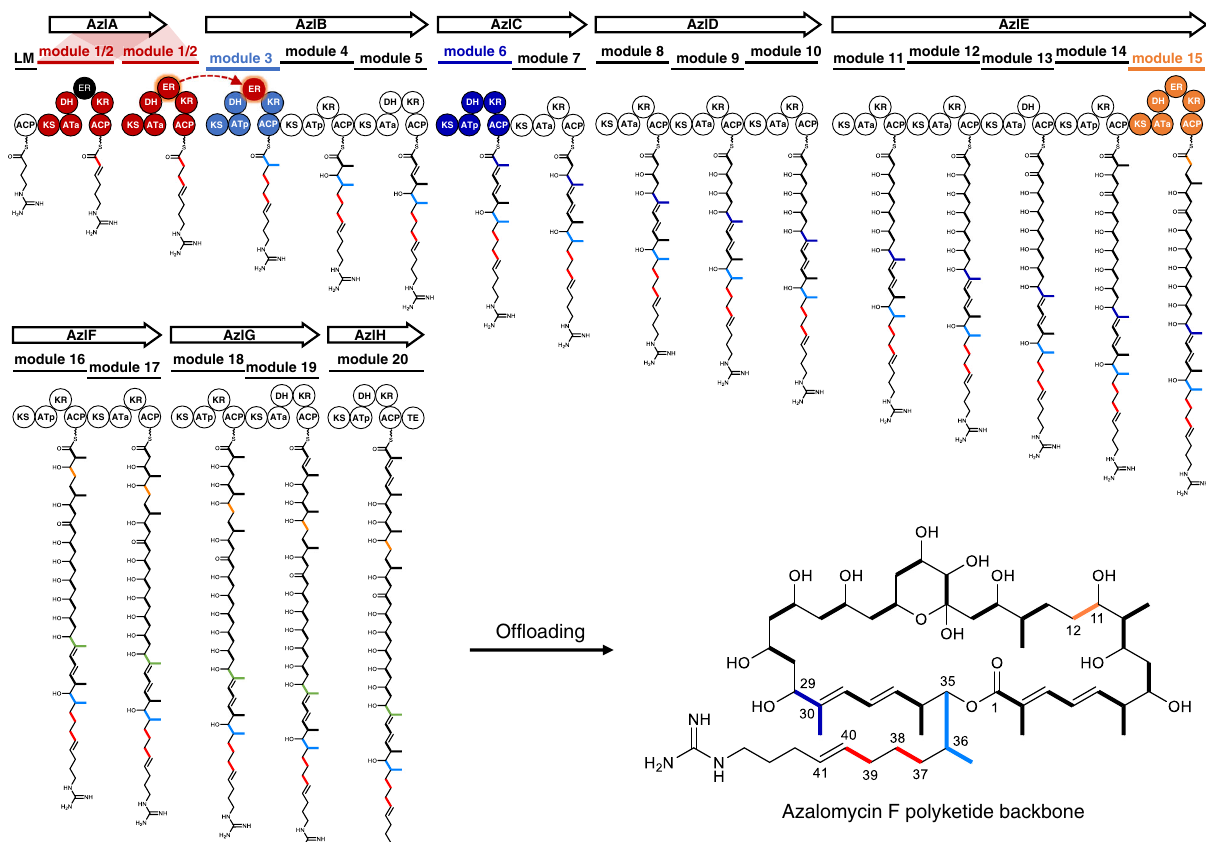
Fig. 1 | Diagram for AZL polyketide backbone biosynthesis. Each circle repre- sents an enzymatic domain in the PKS, in which particularly ATa indicates the domain loading a malonyl-CoA to build an acetate unit (single bold line) and ATp to load a methylmalonyl-CoA to build a propionate unit (bold fold line), respectively. The modules and domains involved in this study are highlighted